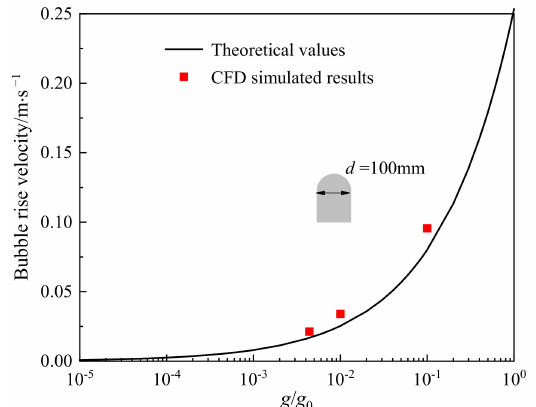
Figure 3. Comparison of bubble rise velocities between theoretical and CFD results under different gravity levels